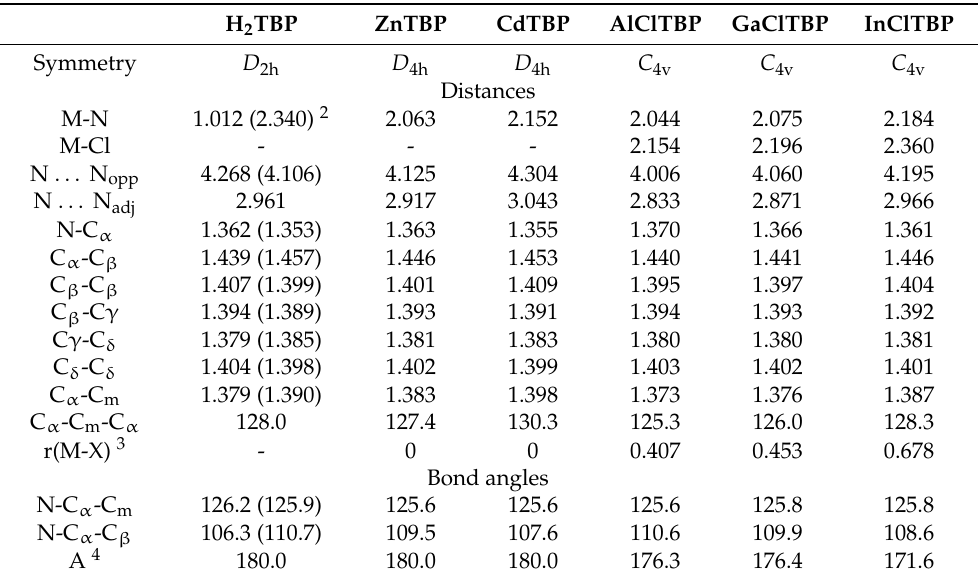
Table 1. Molecular parameters 1 of H 2 -tetrabenzoporphyrin and its metal complexes optimized at PBE0/def2-TZVP level. H 2